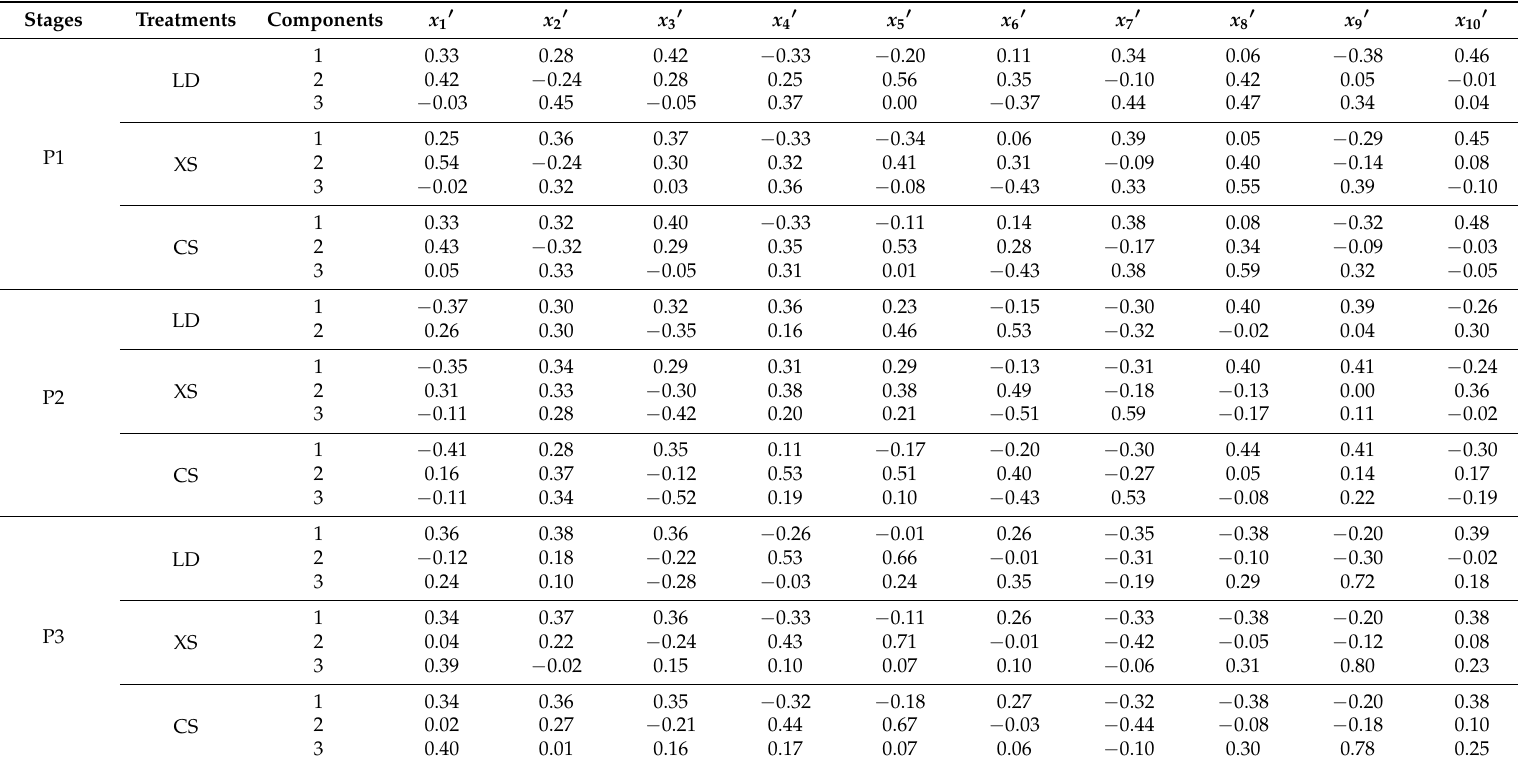
Table A2. Factor loading coefficient of principal